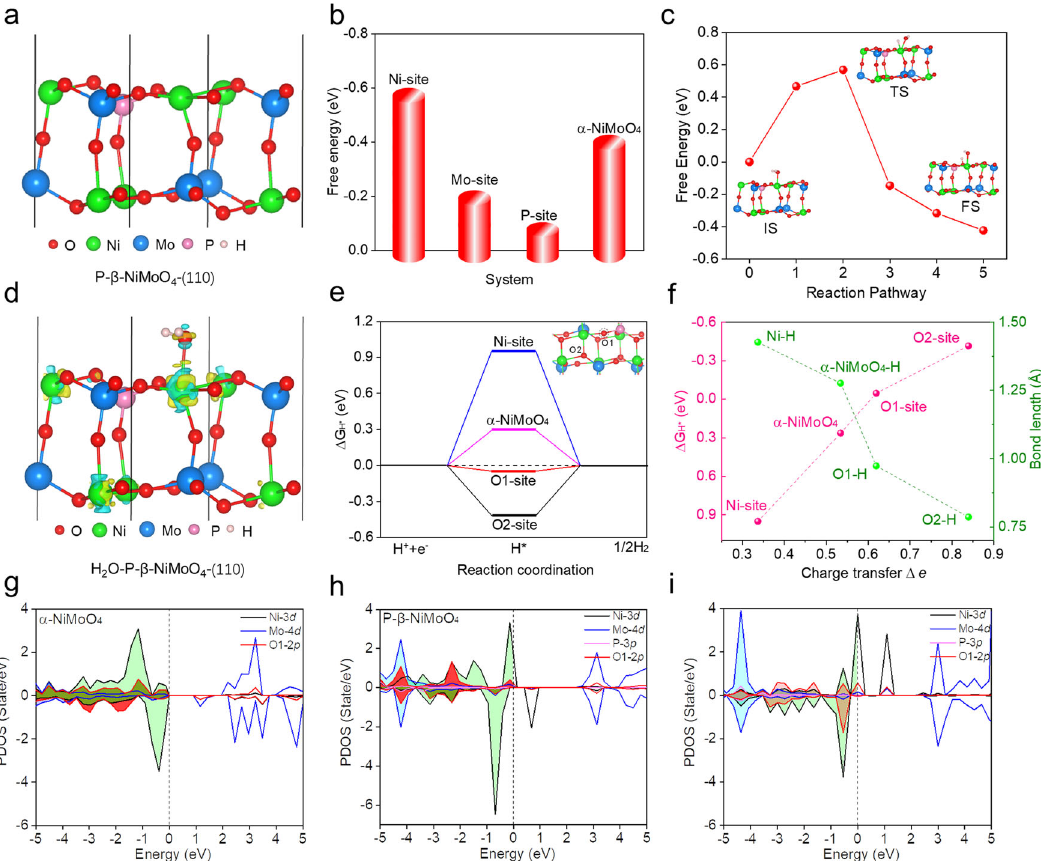
Fig. 4 Calculated adsorption free energy and electronic structure of different adsorbates between α -NiMoO 4 -(110) and P- β -NiMoO 4 -(110) surface. a The optimized structure of P- β -NiMoO 4 -(110). Especially, the Mo atom was substituted by the P atom according to the experiment veri fi cation. b The Gibbs free energy diagram on H 2 O adsorbed on different sites in α -NiMoO 4 -(110) and P- β -NiMoO 4 -(110) surface, respectively. c Water dissociation barrier for reaction pathway of P- β -NiMoO 4 system. The insets are the structure of the corresponding IS (initial state), TS (transition state) and FS ( fi nal state). d The corresponding charge density differences of H 2 O adsorbed on Ni sites in P- β -NiMoO 4 . The yellow and blue regions indicate the accumulated or dispersed amount of electron states of atoms around the interface, respectively. e Hydrogen adsorption free energy ( Δ G H* ) in different exposed atoms in P- β -NiMoO 4 -(110). Here, these exposed atoms are considered as the catalytic sites for HER. f Linear correlation between Δ G H* , P- β -NiMoO 4 -H bond length, α -NiMoO 4 -H bond length and the amount of charge transfer Δ e of various active sites in different phase of NiMoO 4 surface. g Projected density of state (PDOS) of various exposed atoms in α -NiMoO 4 -(110). h , i PDOS before ( h ) and after ( i ) H 2 O being adsorbed on the Ni site of P- β -NiMoO 4